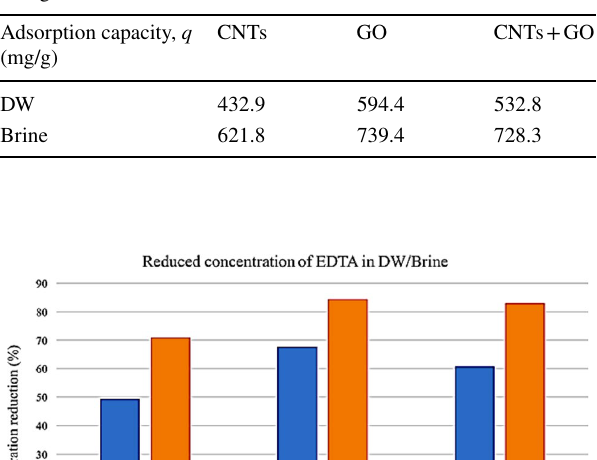
Table 2 Adsorption capacity of different nanomaterials in varying